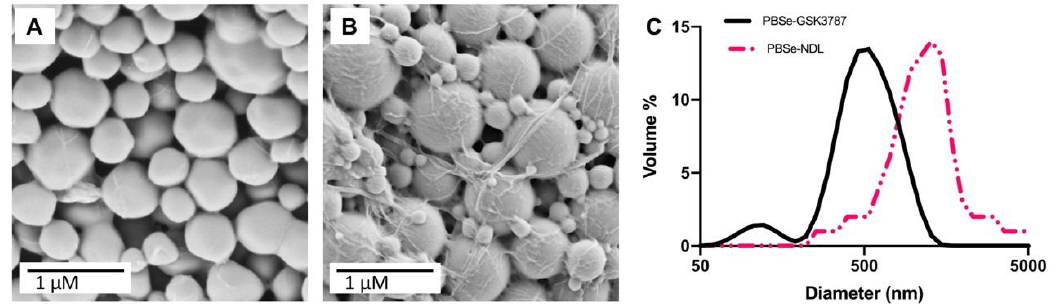
Figure 2. Scanning electron micrographs of particles ( A ) PBSe-GSK3787 and ( B ) PBSe-NDL (non-drug-loaded) showing their spherical morphologies and diameters in the solid state; ( C ) Representative dynamic light scattering (DLS) diameter distributions by volume % of PBSe-GSK3787 and PBSe-NDL particles showing the smaller diameters of the drug-loaded particles.